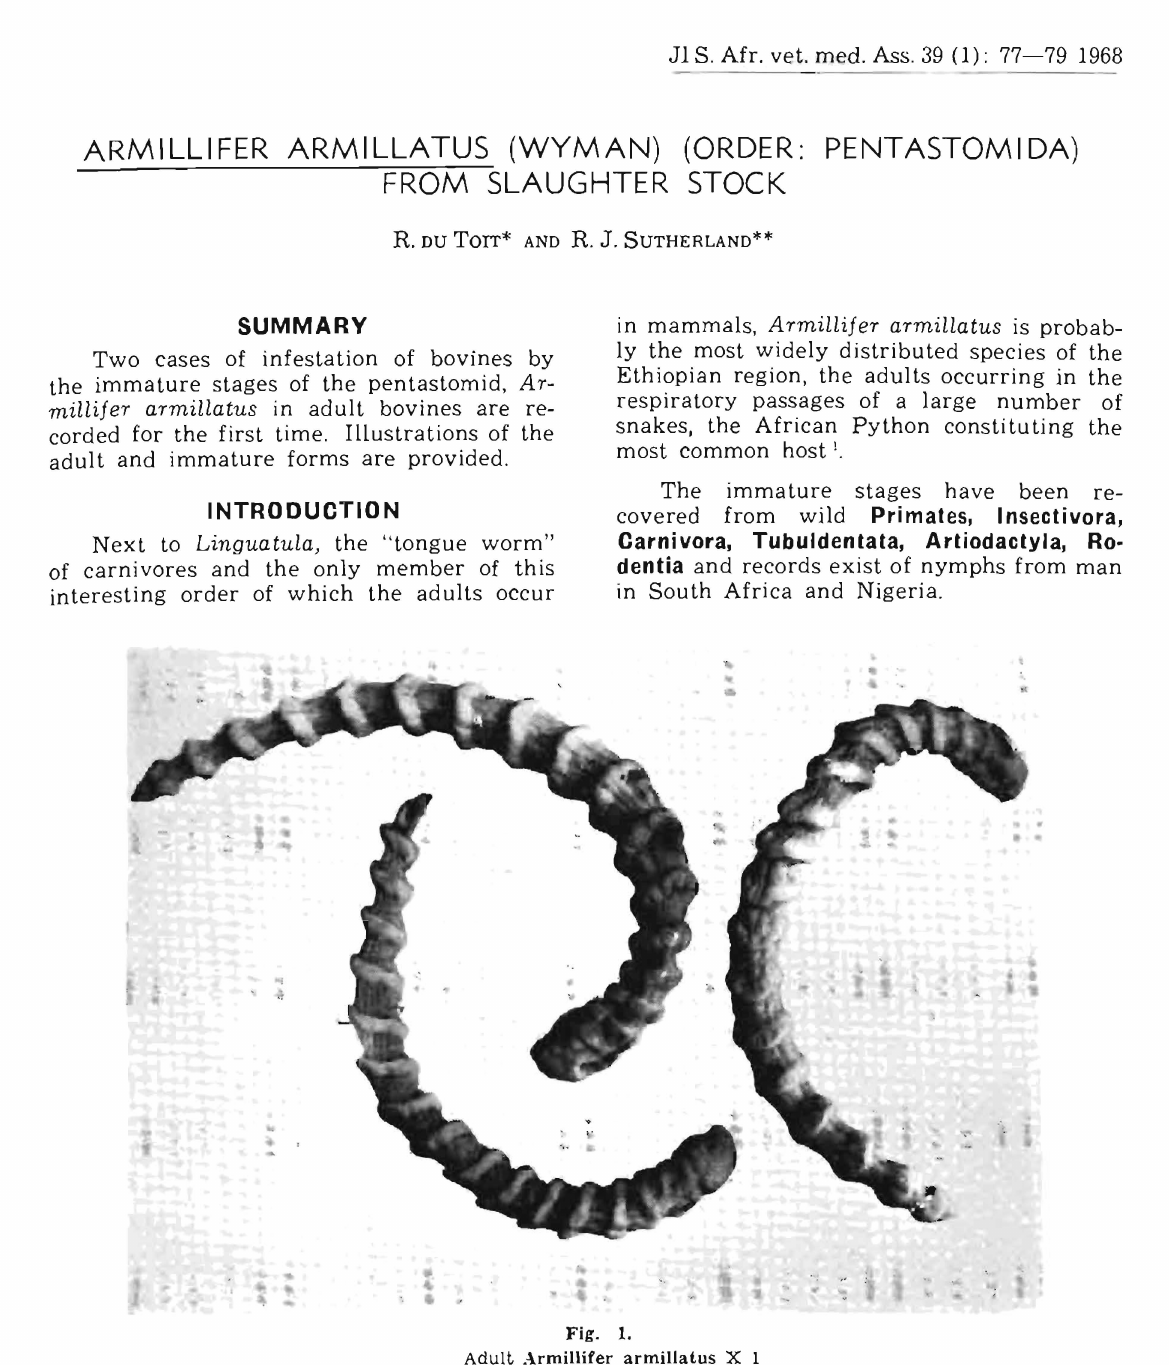
Fig. 1. Adult .\rmillifer armillatus X